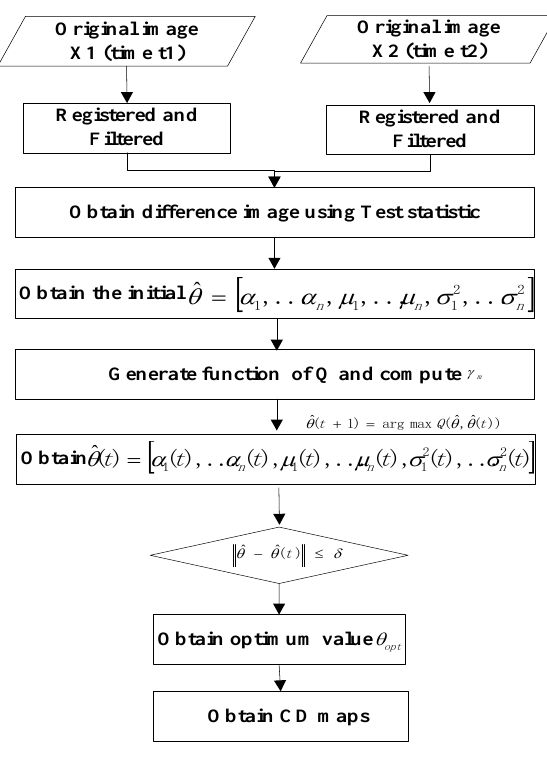
Figure 1. The procedure of this study The basic processing flow of the proposed method (Figure 1) consists of data preprocessing, likelihood-ratio parameter construction, change information automatic extraction with Gaussian mixture model algorithm and precision evaluation. First, speckle noise is removed by Refined_Lee filtering for the two registered fully polarimetric SAR images. As the coherency matrix C3 or covariance matrix T3 of fully polarimetric SAR data follows a complex Wishart distribution. The likelihood- ratio parameter is built by a test statistic based on Wishart distribution to represent change features and the difference image also is obtained. Then the data distribution of the difference image computed from satellite images of the same scene acquired at different time instances is modeled by using the expectation maximization (EM) iterative algorithm and Gaussian mixture model algorithm and it also becomes a reality that the change information is automatic extracted. Finally, the precision of change detection result is